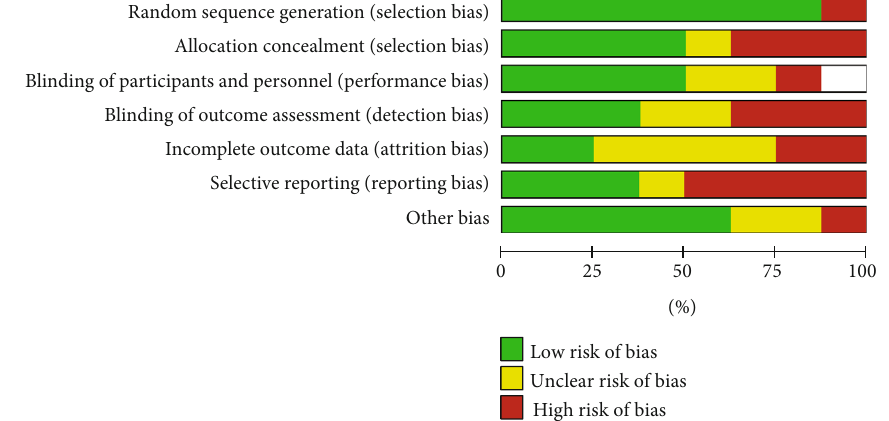
Figure 2: The risk of bias was included in the meta-analysis.